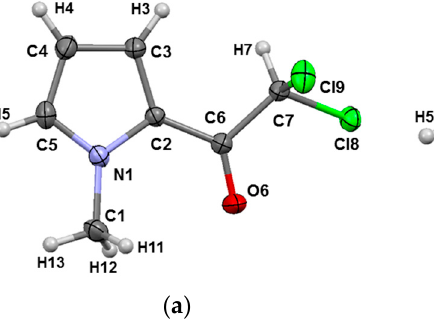
Figure 1. Molecular structures of ( a ) 2,2-dichloro- 1- (1-methyl-1H- pyrrol- 2-yl)ethan-1-one ( I ), ( b ) 2-chloro-1-(1H-pyrrol-2-yl)ethan-1-one ( II ) and ( c ) methyl 1H-pyrrole-2-carboxylate ( III ). Atomic displacement ellipsoids are drawn with a 50% probability level.